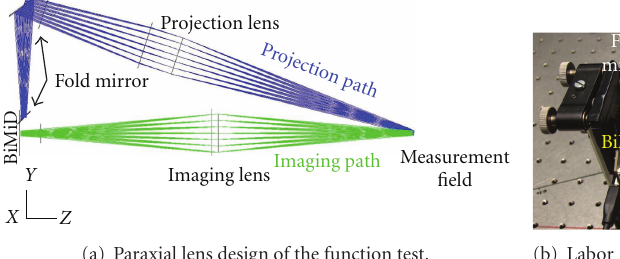
(b) Labor setup of the paraxial lens design. The red path des- cribes the projection path and the blue describes the imaging path. Figure 5: Paraxial lens design and laboratory setup of the function test of an 3D sensor system. On the left-hand side the bi-directional OLED microdisplay is positioned. The projection path is folded by a fold mirror. The imaging path is unfolded. Both optical system magnifications are approximately β (cid:3) ≈ − 1. The diagonal of the projection and imaging field is 3mm. At first the object field is projected into the measurement field, and then the illuminated measurement field is imaged onto the bi-directional microdisplay (detection plane).